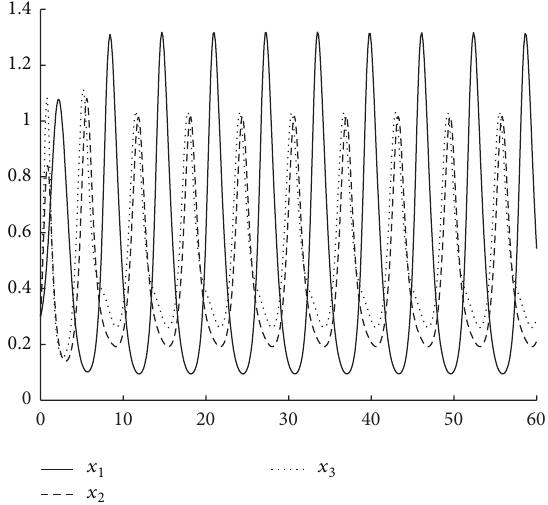
Figure 3: Dynamic behaviors of system (66). Here, we take the initial conditions 𝑥 1 (𝜃) ≡ 𝑥 2 (𝜃) ≡ 𝑥 3 (𝜃) ≡ 𝑢 1 (𝜃) ≡ 𝑢 2 (𝜃) ≡ 𝑢 3 (𝜃) = 0.3 for all 𝜃 ∈ (−∞,0]